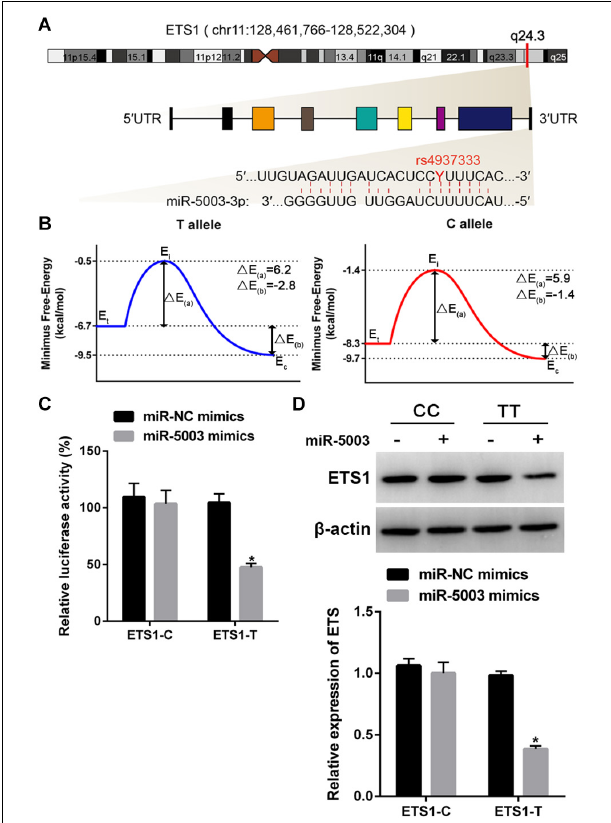
FIGURE 4 | Functional validation of the miR-5003-binding site in the ETS1 3 (cid:48) -UTR and the influence of SNP rs4937333. (A) ETS1 gene structure and T/C polymorphism in the ETS1 3 (cid:48) -UTR at the miR-5003-binding site. chr, chromosome. (B) Binding energy diagram demonstrating the energy transformation of the process of miR-5003 binding to the ETS1 3 (cid:48) -UTR. E i , E intermediate ; E t , E target ; E c , E complex ; (cid:49) E ( a ) is the energy difference between the transition state and the original target, and the binding energy, (cid:49) E ( b ) , is the energy difference between the complex and the target. (C) The effect of the SNP rs4937333 on miR-5003-mediated transcriptional repression in 293T cells. Forty-eight hours after transfection with the reporter gene and miR-5003 mimic, cells with the T allele construct had significantly less relative luciferase activity than in cells with the reporter bearing the C allele. (D) The suppressive effect of miR-5003 on ETS1 gene expression was abolished by rs4937333 C in the ETS1 3 (cid:48) -UTR. ETS1 -T or ETS1 -C constructs were cotransfected into 293T cells with miR-5003 mimic or miR-NC. ETS1 expression in 293T cells was analyzed by Western blotting at 48 h after transfection. ∗ P < 0.05 vs. miR-NC; n =